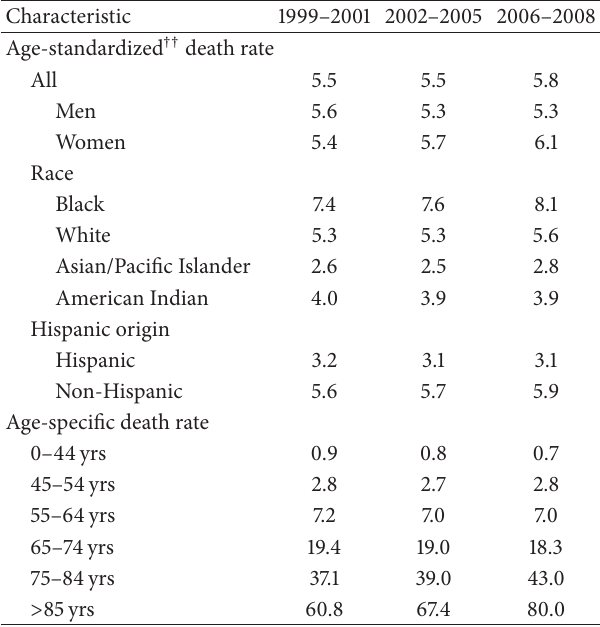
Table 1: Age-standardized and age-specific death rates ∗ for pul- monary hypertension † as any contributing cause of death for groups defined by selected characteristics and by period: United States,